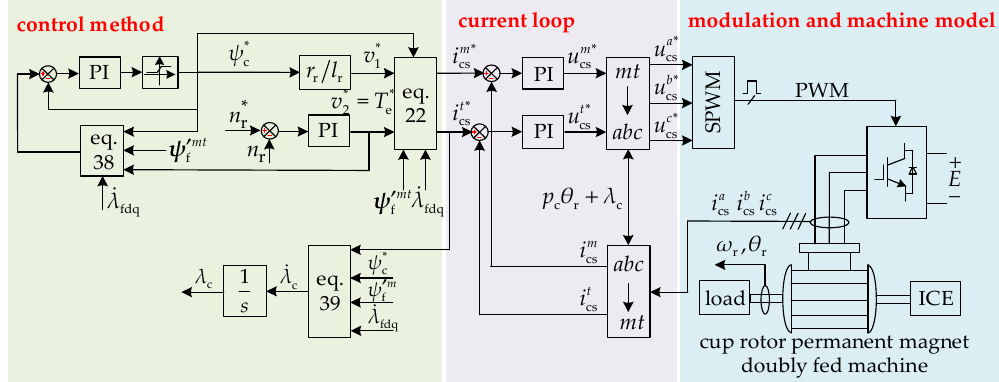
Figure 8. Control block diagram of cup rotor permanent-magnet doubly fed machine.